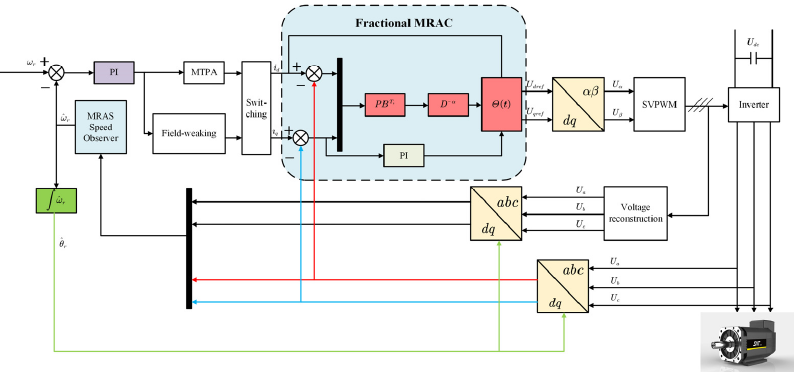
Figure 4. Control schematic of permanent-magnet synchronous motor based on FOMRAC and MRAO.